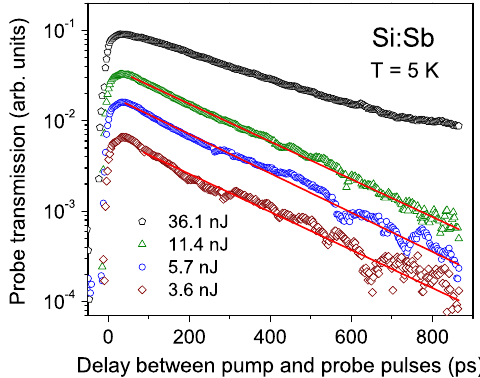
FIG. 5. Same as Fig. 3 for the 1 s (cid:4) 2 p 0 transition in Si:Sb at 5 K. Also shown are fits using a single-component decay (unlike the acceptors which have two-component